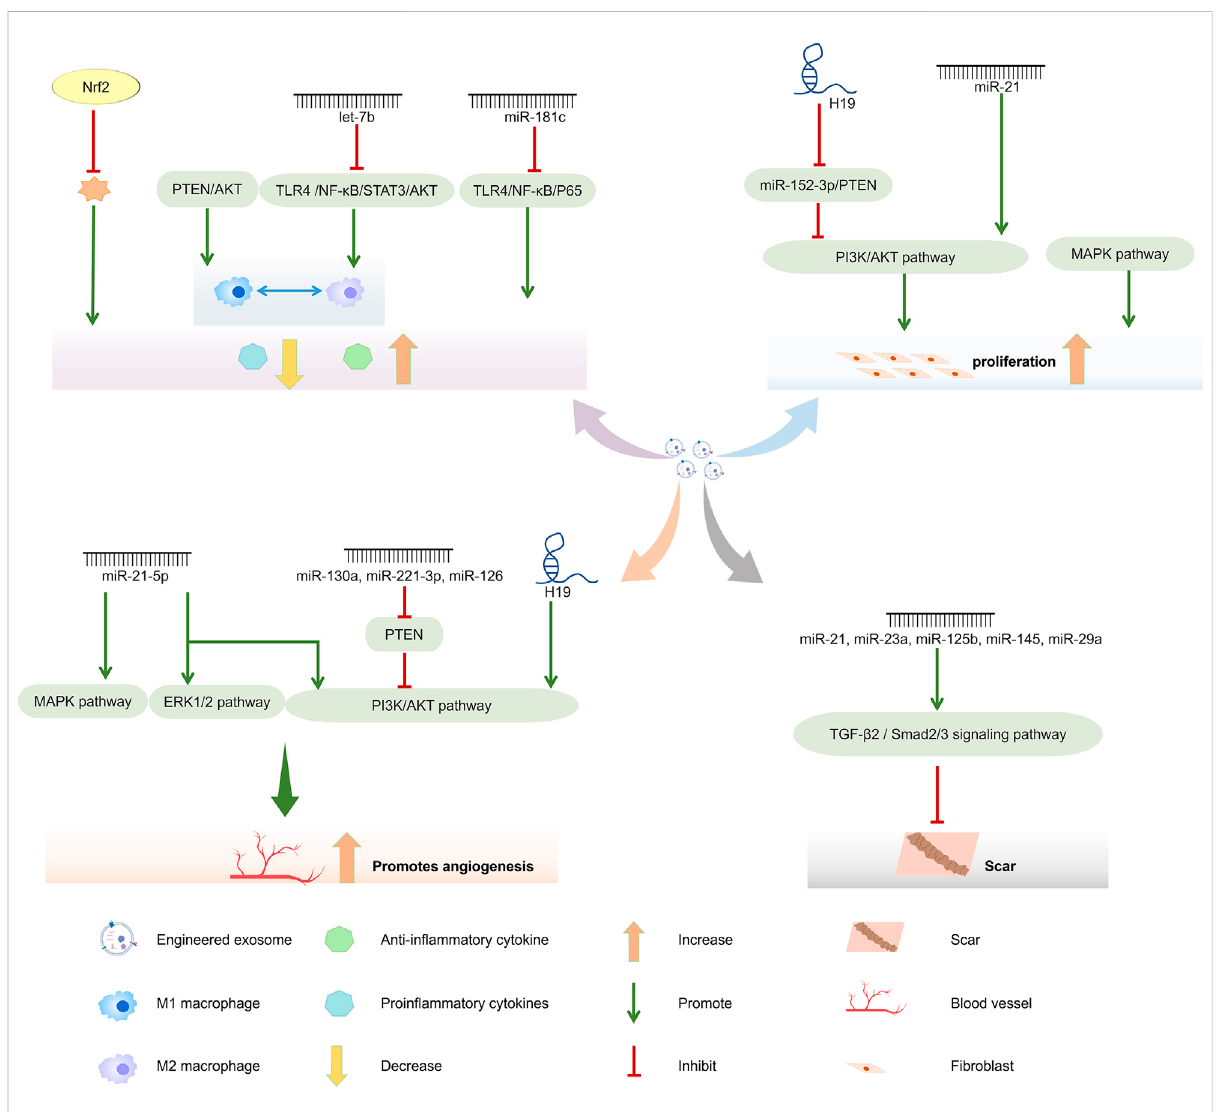
FIGURE 3 Wound healing promoting mechanism of engineered stem cell